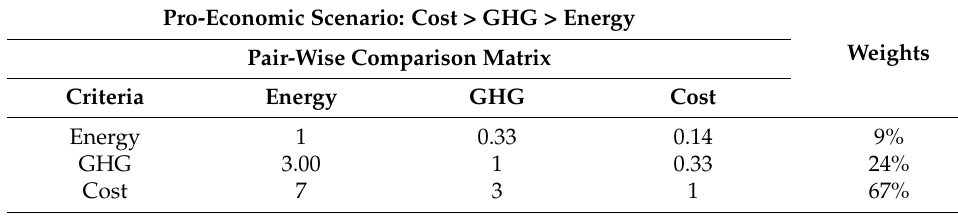
Table 2. Environmental and economic criteria for weighting scenarios based on AHP.